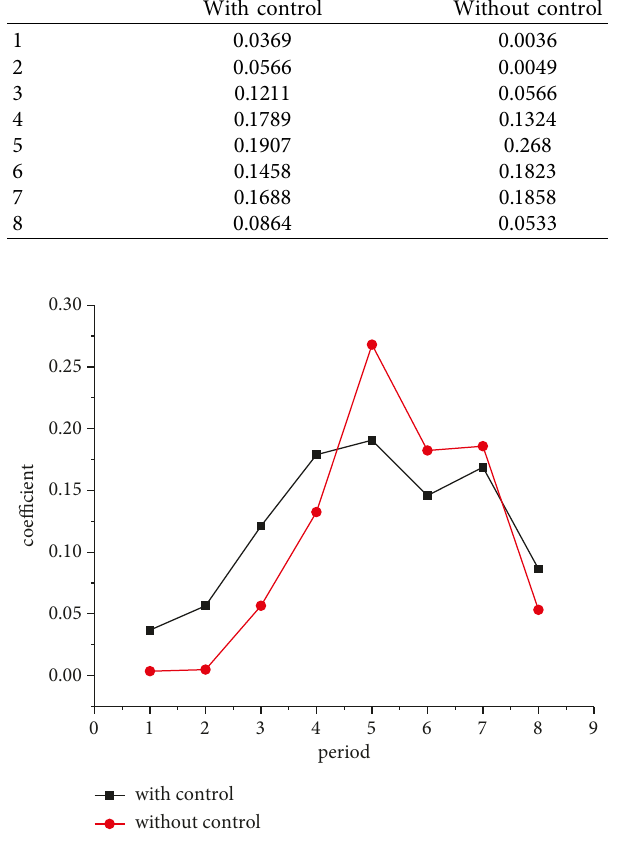
Figure 10: Comparison of equalization coefficients with and without